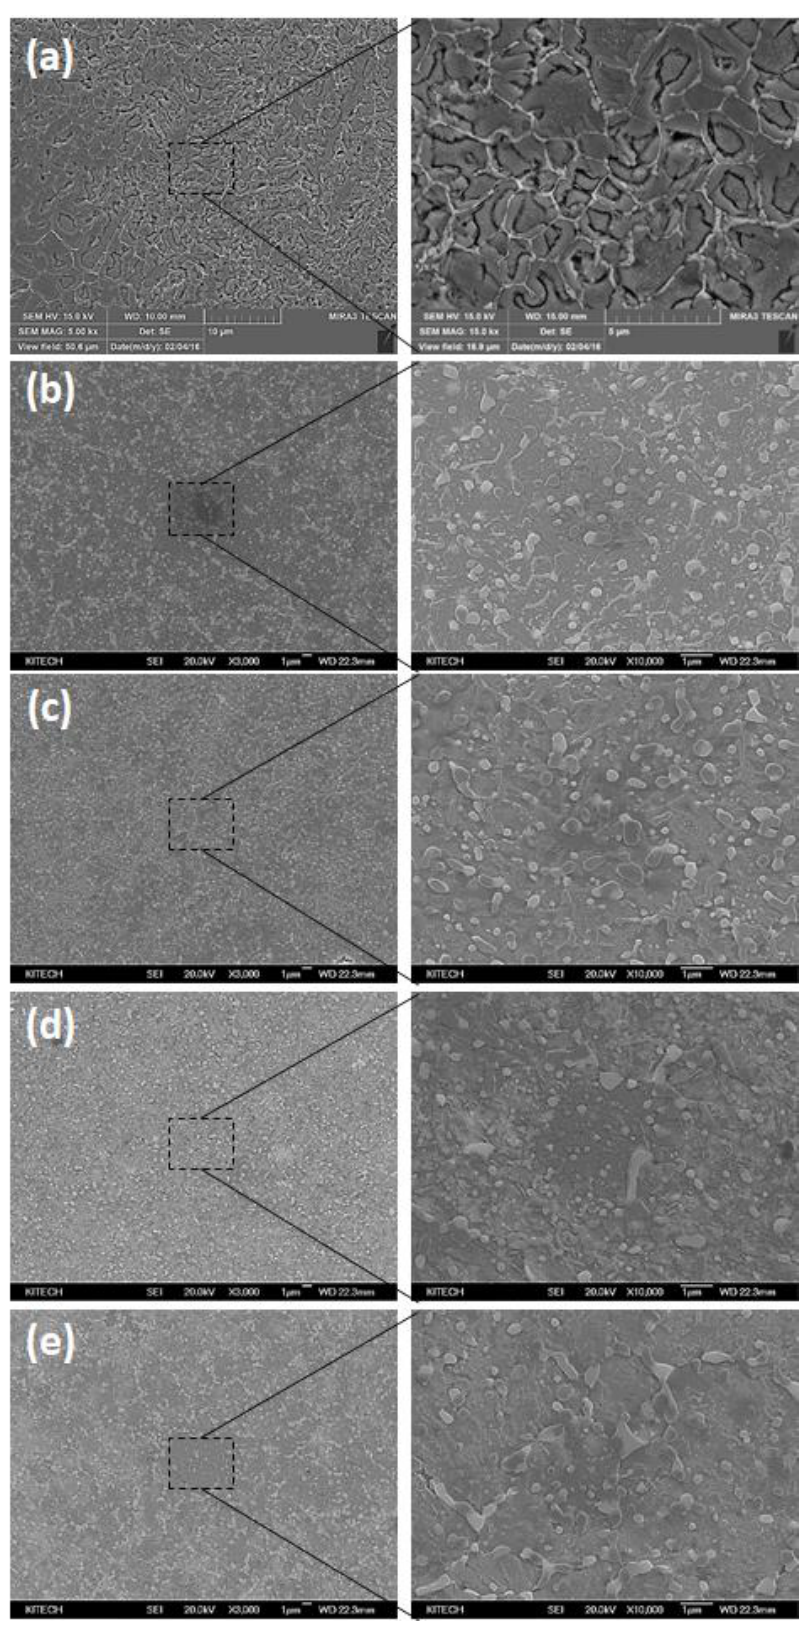
Figure 5. Microstructures of the M4 deposited layer after the post-heat-treatment condition: ( a ) as-deposited; ( b ) A; ( c ) F; ( d ) AT; ( e ) FT.